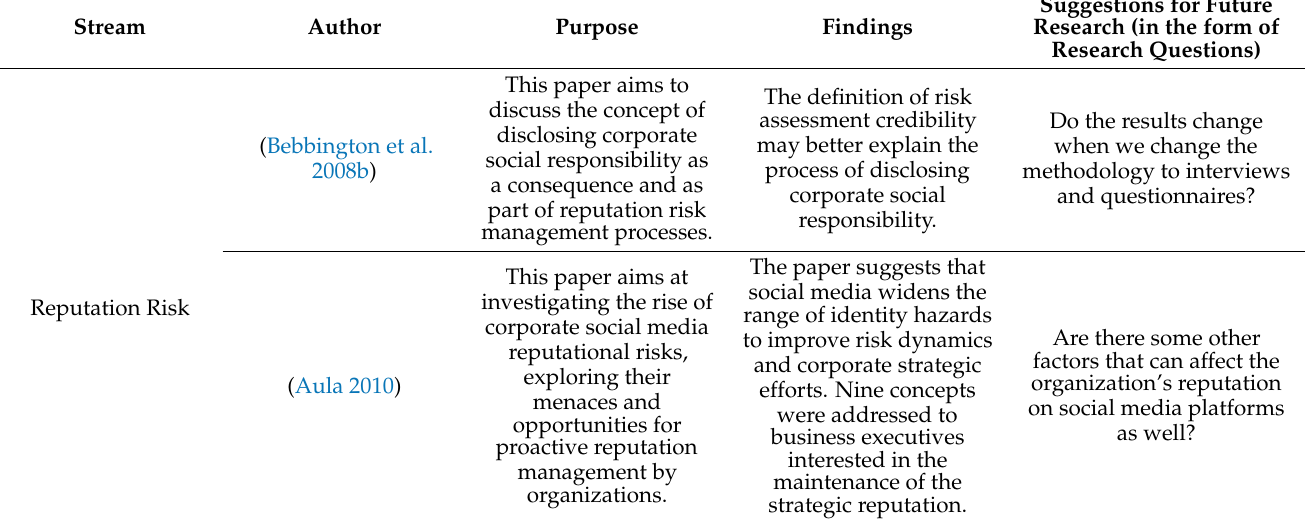
Table 7. Cluster